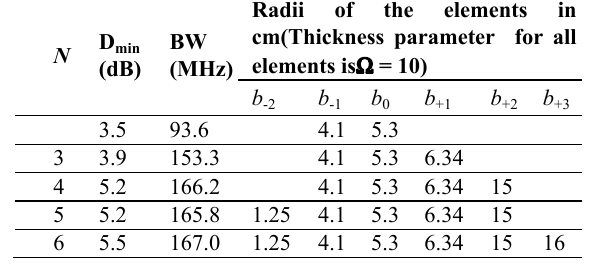
Table 2: Different CCLAs in the UHF RFID bands.